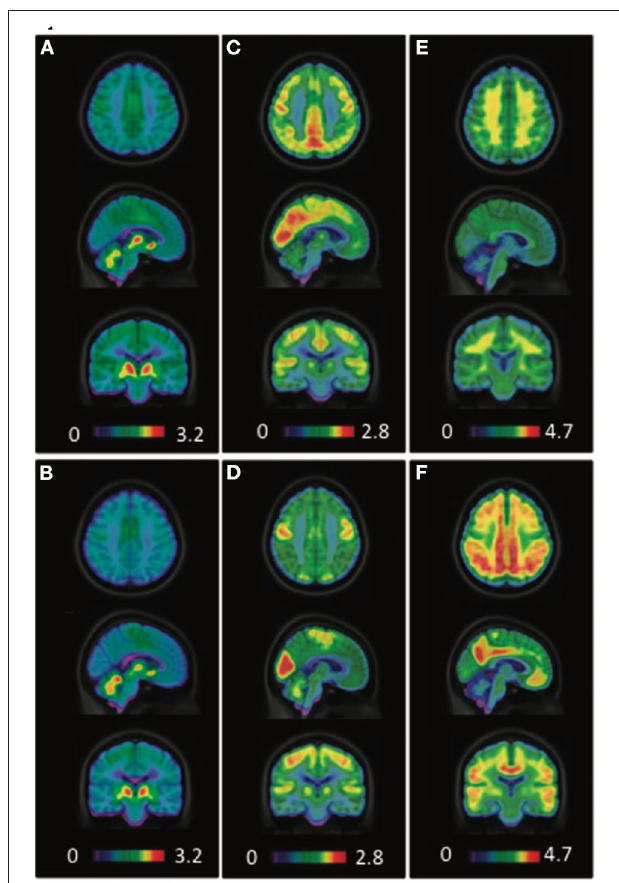
FIGURE 7 | Averaged [ 18 F]FEOBV VAChT PET (A,B) , [ 18 F]FDG PET (C,D) , and [ 18 F]NAV4694 A β PET (E,F) images of healthy controls (A,C,E) and AD patients (B,D,F) . PET images in control subjects revealed the greatest [ 18 F]FEOBV uptake in brain areas known to be the most innervated by the cholinergic systems, including the striatum, thalamus, cerebral cortex as a whole, hippocampal area and cerebellum (A) . In AD patients, PET imaging revealed a significant reduction of [ 18 F]FEOBV uptake in comparison with control subjects (B) . Distinct cerebral hypometabolism (D) and amyloid deposition (F) were seen in the AD patients, as compared to control subjects (C,E) . Courtesy from Aghourian et al.